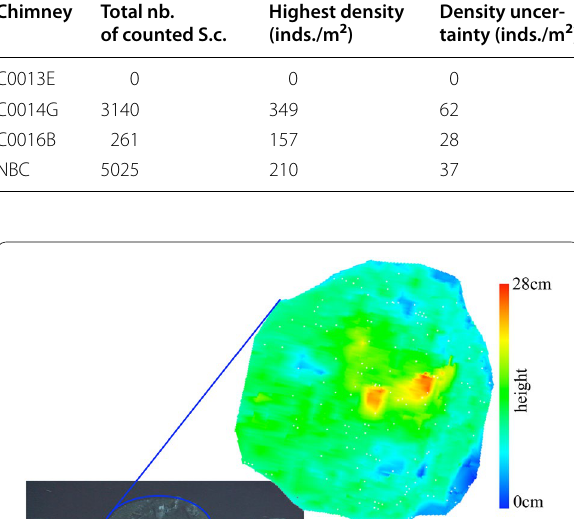
Table 1 Number and density of S. crosnieri (S.c.) identified in the Iheya North field drilling sites Chimney Total nb. of counted S.c.